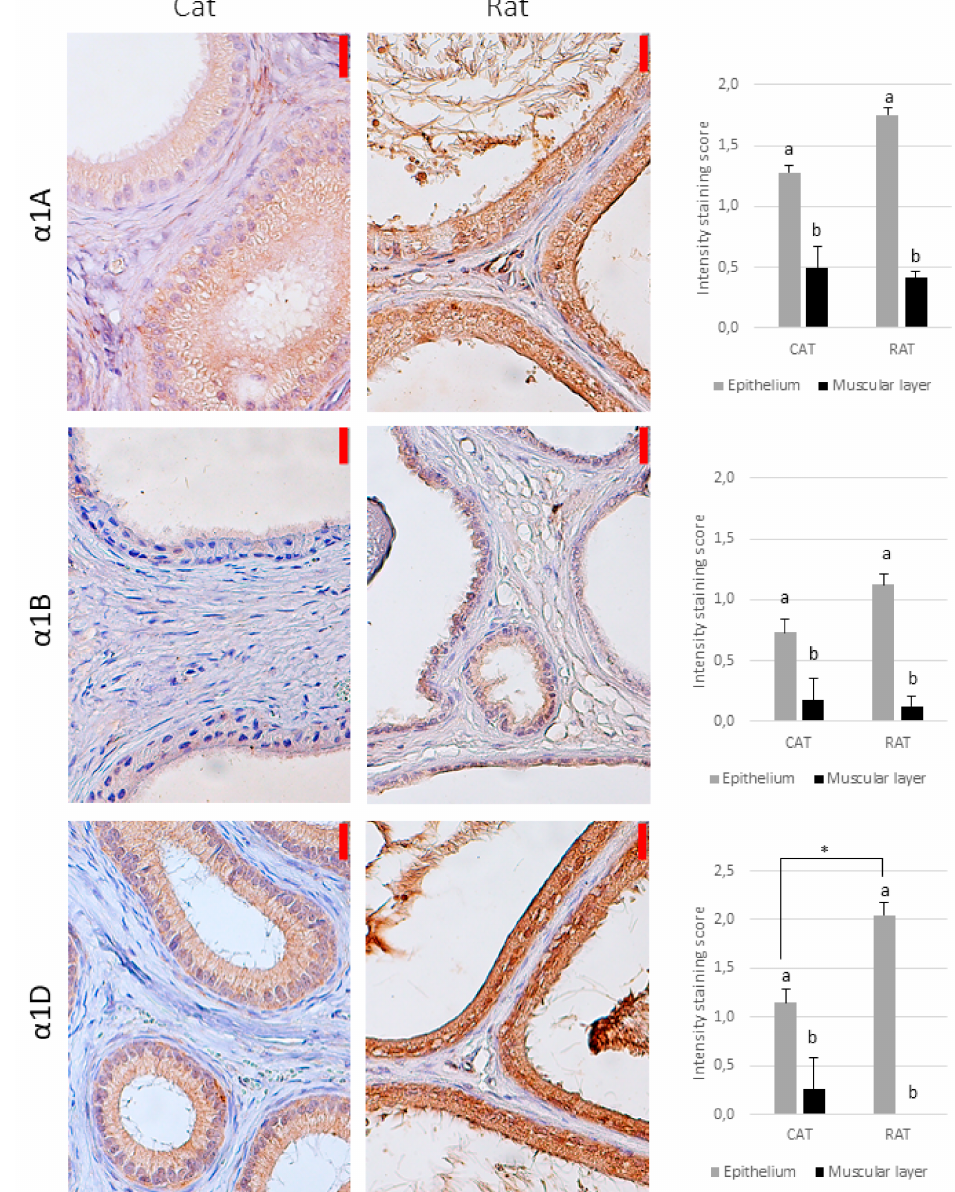
Figure 2. The immunohistochemical localization of the α 1-adrenoceptors in the feline and rat reproductive tract − representative pictures of the epididymis (counterstained with Hematoxylin, magnification 400 × ). The red bar on the upper right of each image represents 20 µ m. The graphs on the right present the average reaction intensity score ( n = 6). Because of the lack of difference between the regions for most of the receptors investigated, the data are shown as the average intensity of staining for the regions analyzed and SEM, for the sake of clarity. The different letters above the bars (a, b) indicate significant ( p < 0.05) differences between the epithelium and muscular layer within a species. An asterisk (*) indicates a significant difference between the